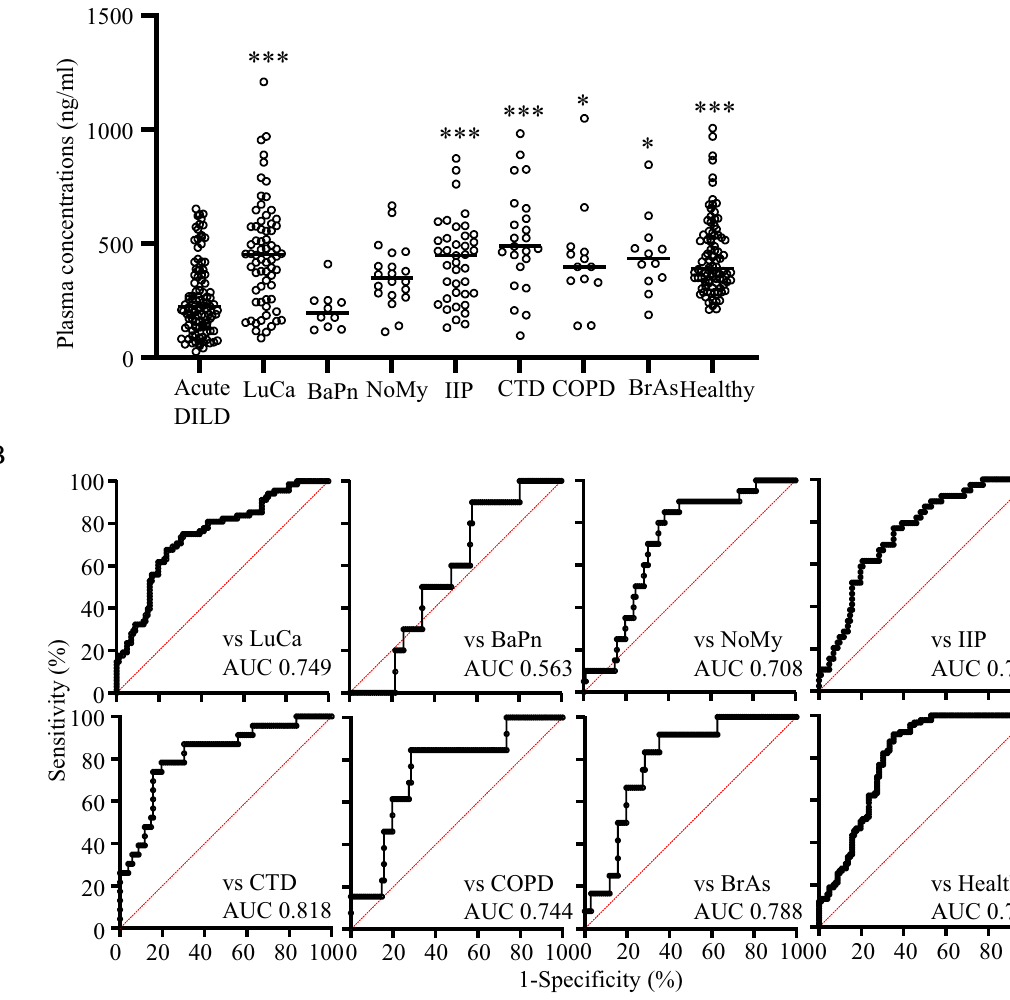
Figure 5. Ability of LPC(14:0) to discriminate DILD from other lung diseases and healthy volunteers. ( A ) Plasma LPC(14:0) concentrations in acute phase DILD patients, other lung diseases, and healthy volunteers. *** p < 0.001, * p < 0.05 vs. acute phase DILD. LuCa; lung cancer, BaPn; bacterial pneumonia, NoMy; nontuberculous mycobacteriosis, IIP; idiopathic interstitial pneumonia, CTD; lung disease associated with connective tissue disease, COPD; chronic obstructive pulmonary disease, BrAs; bronchial asthma, Healthy; healthy volunteer. ( B ) ROC curve of LPC (14:0) concentrations between acute phase DILD patients and other